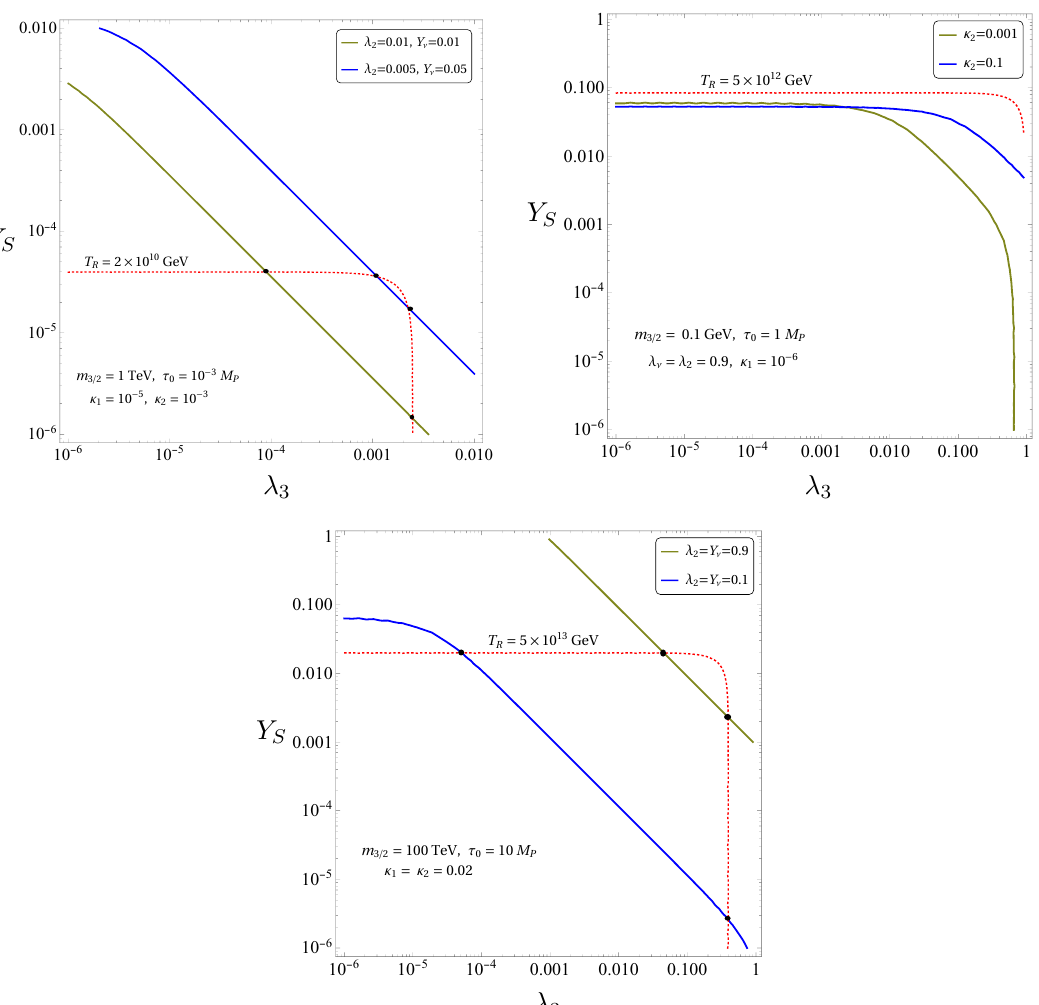
Figure 7 . The regions of parameter space in the plane ( λ 3 , Y S ) allowed by neutrino masses and reheating temperature constraints. The solid lines represent the lightest neutrino eigenstate | m O (0 . 1) eV, while the dotted curve represent the constraints from reheating.